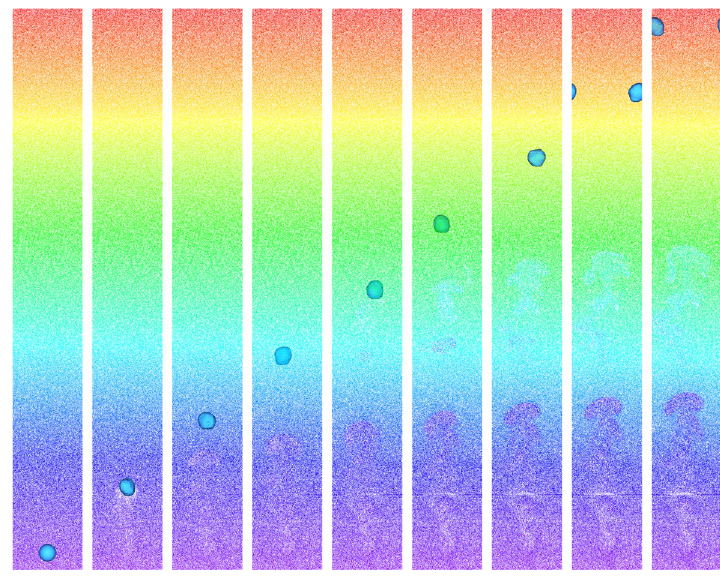
Fig. 3 Illustration of the simulation for the rising bubble (particles stick to the bubble). Particles are colored by initial z-position. Images are not in uniform time intervals, but in uniform intervals of traveled distance. The rising bubble initially plunges a void in particle concentration that quickly disappears again due to mixing. This figure is provided as a video in the Supplementary files